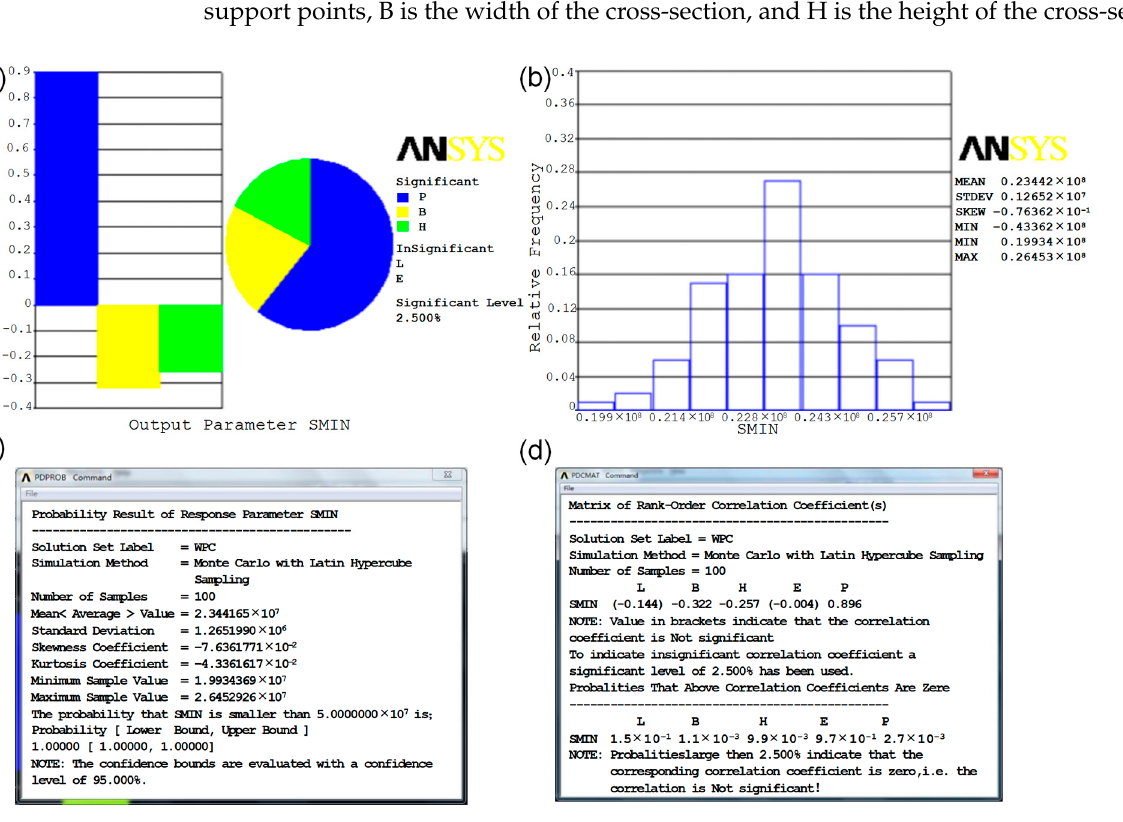
Figure 7. ( a ) Sensitivity of SMIN to input random variables; ( b ) histogram of maximum stress; ( c ) reliability results for specimens; ( d ) correlation coefficients of stresses with each input parameter.